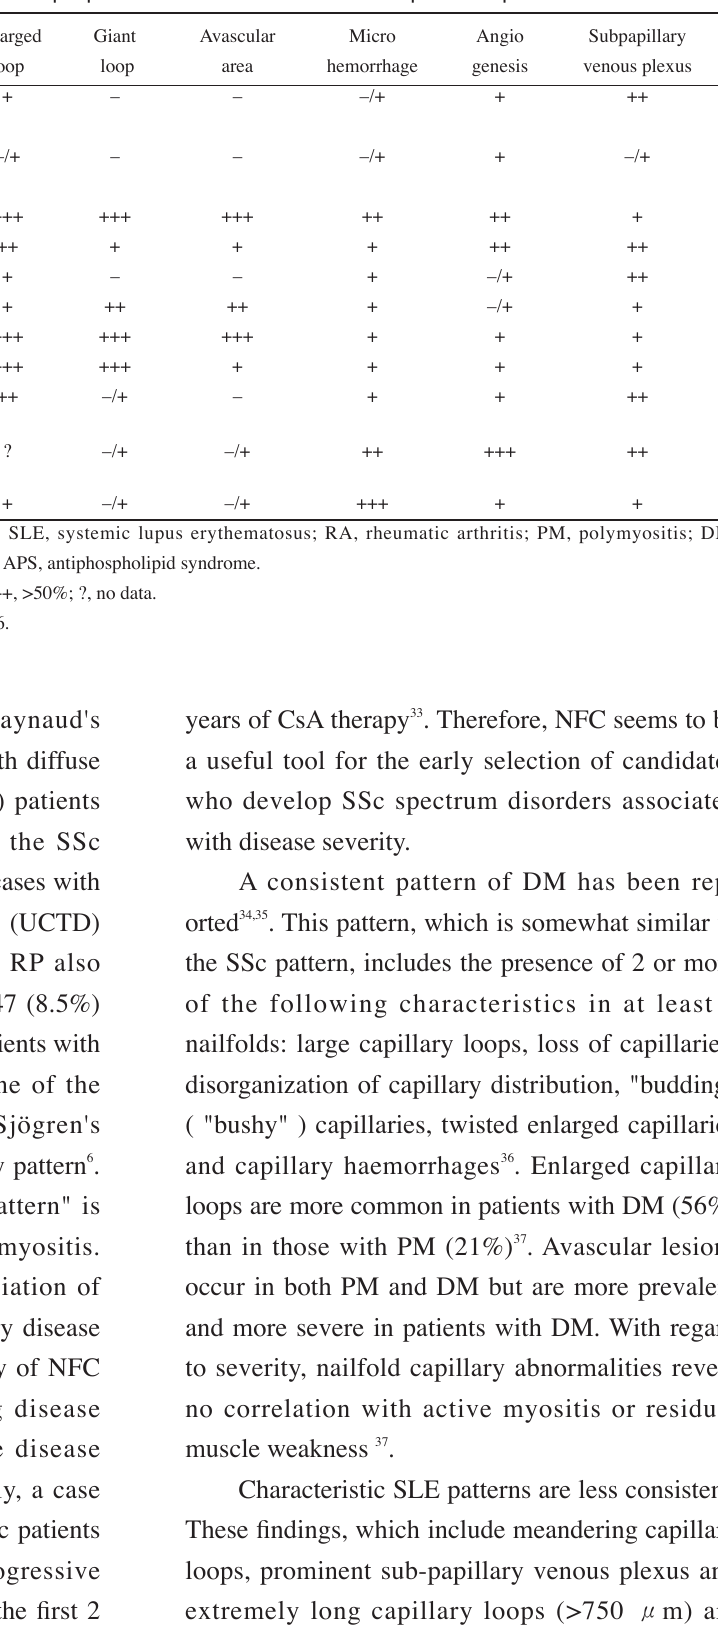
Table 2. Summary of the frequencies of capillaroscopic patterns in rheumatic diseases reported in previous studies# Long